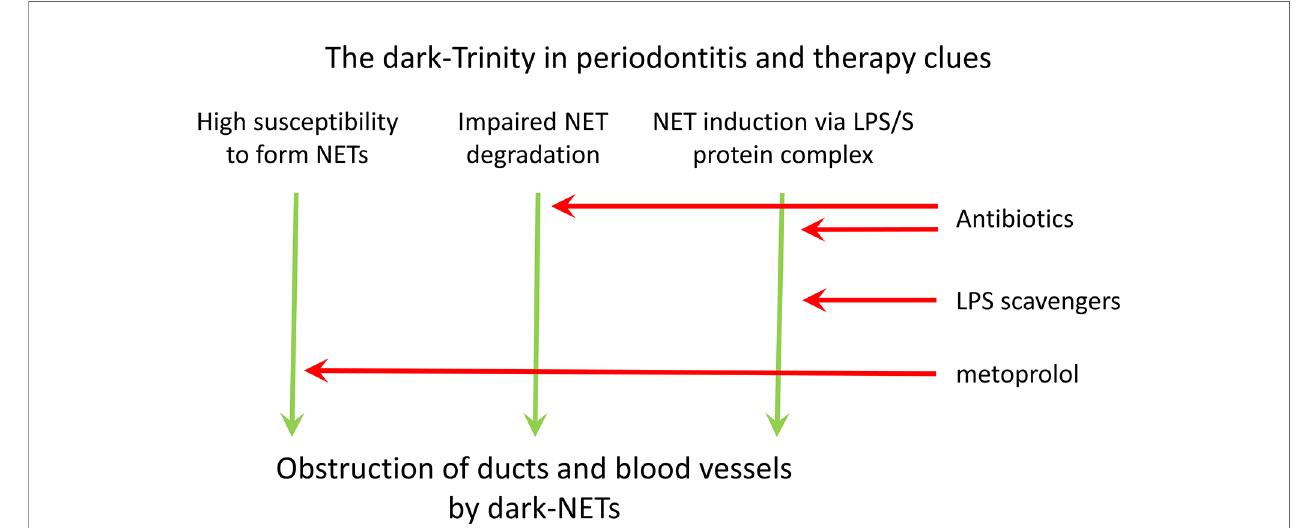
FIGURE 1 | Pathogenic factors and treatment approaches in severe COVID-19 course in patients with